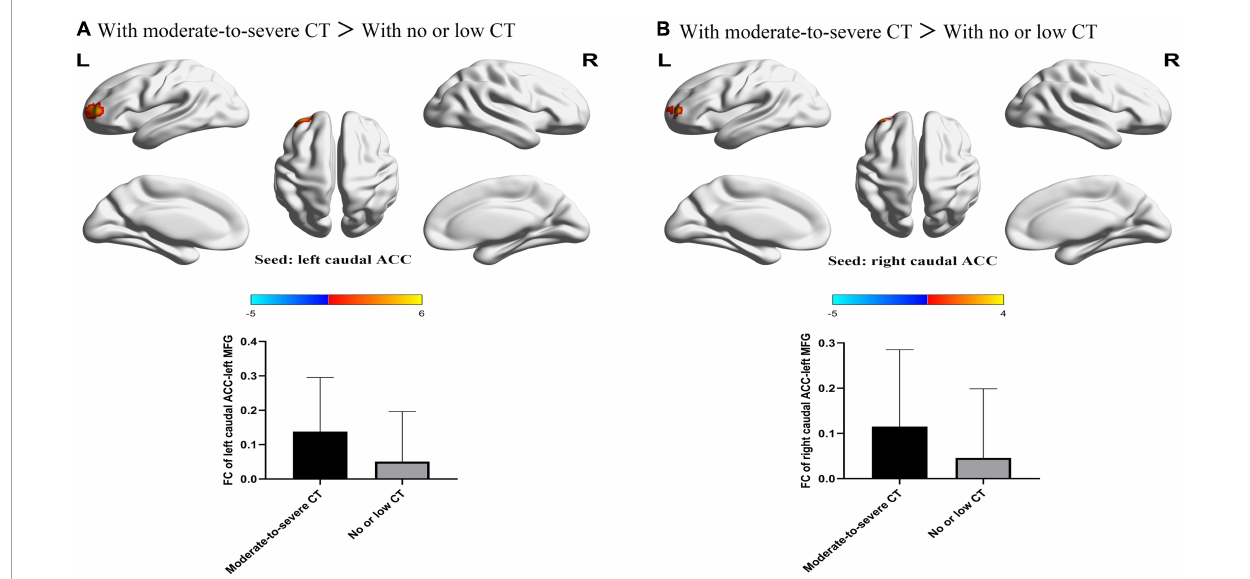
FIGURE2 The significant main effect of CT level on FC between bilateral caudal ACC and the left MFG. (A) Individuals with a history of moderate-to-severe CT exhibited increased FC between the left caudal ACC seed and left MFG compared to individuals with no or low CT. (B) Individuals with a history of moderate-to-severe CT exhibited increased FC between the right caudal ACC and the left MFG compared to individuals with no or low CT. L, left; R, right; MDD, major depressive disorder; FC, functional connectivity; ACC, anterior cingulate cortex; MFG, middle frontal gyrus.